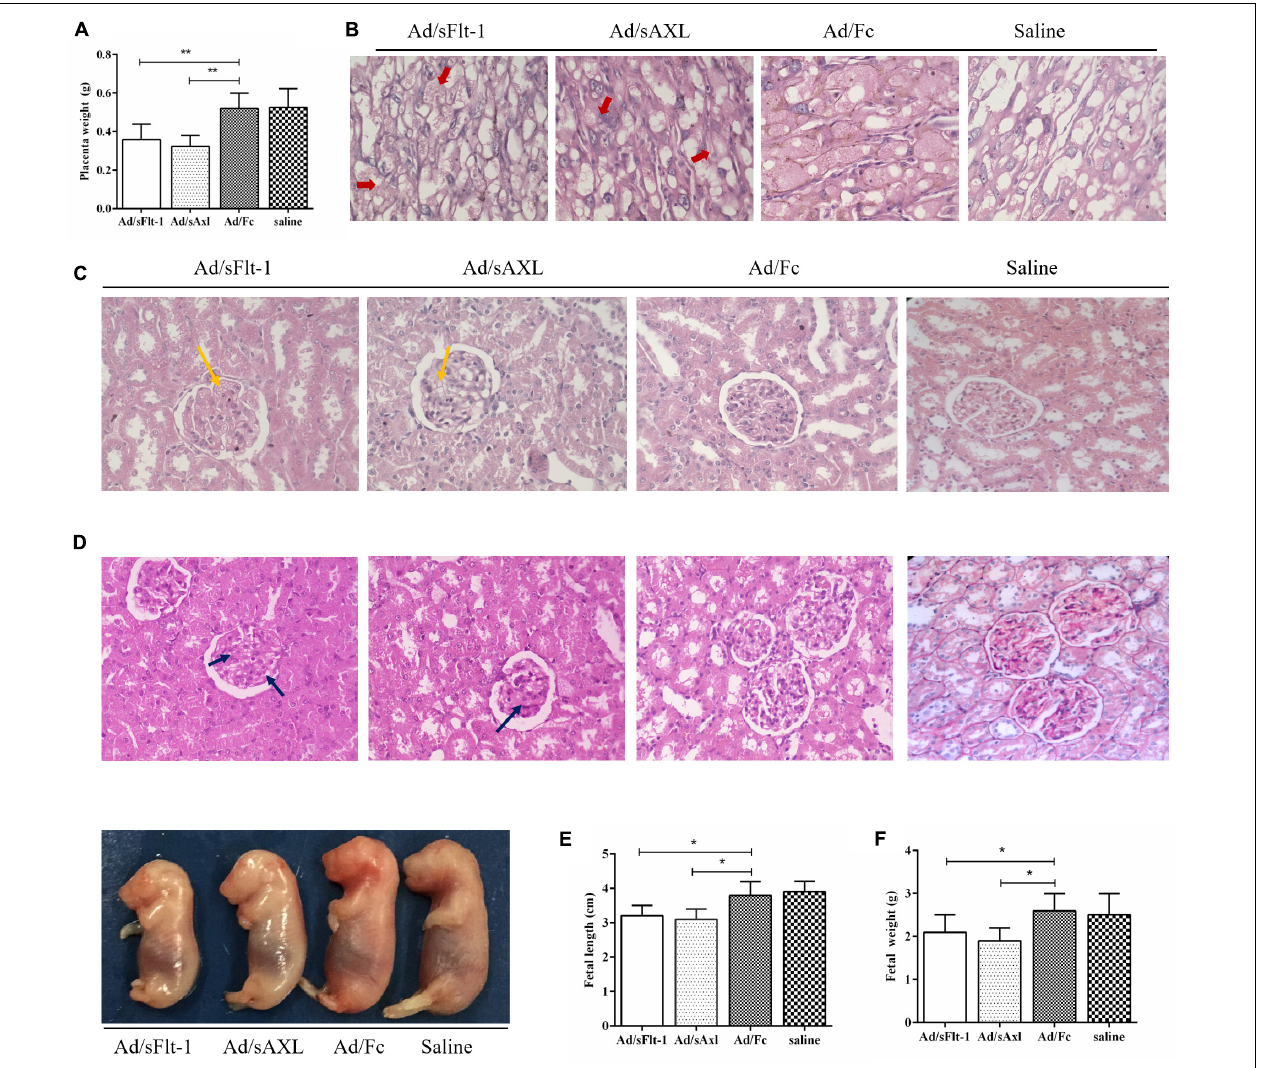
Frontiers in Physiology |